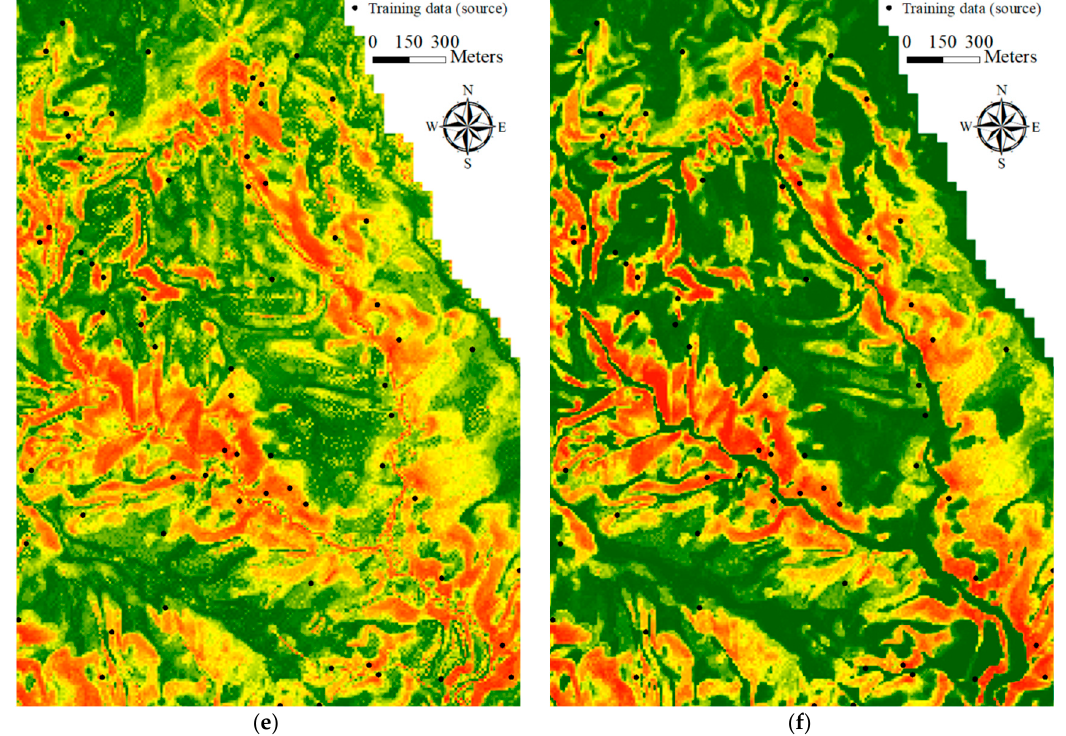
Figure 10. Generated landslide susceptibility maps: ( a ) Model-1 with cost setting (C=5), ( b ) Model-2, ( c ) Model-3, ( d ) difference of subtracting (c) from (a), ( e ) zoomed-in Model-2 result, ( f ) zoomed-in Model-3 result.